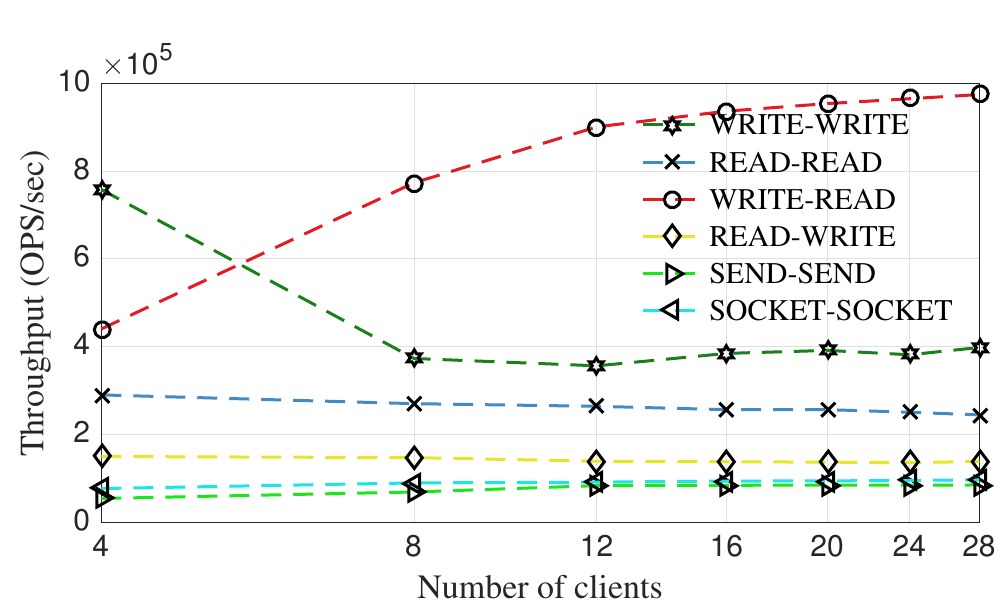
Figure 13. Throughput of communication